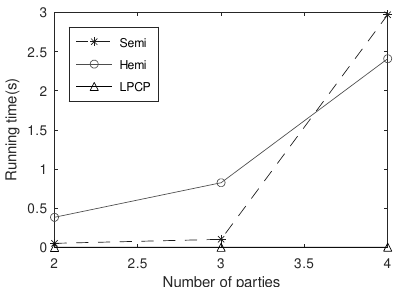
Figure 5. Running time of Semi, Hemi and LPCP in different party numbers conditions.